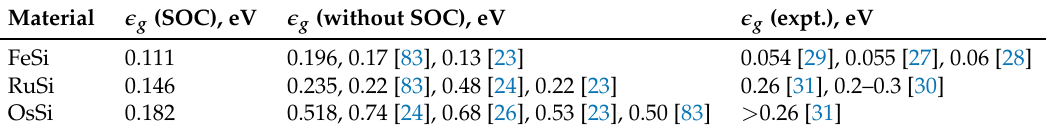
Table 4. Energy gaps in semiconducting monosilicides of Fe, Ru, and Os crystallizing in B20 structure.